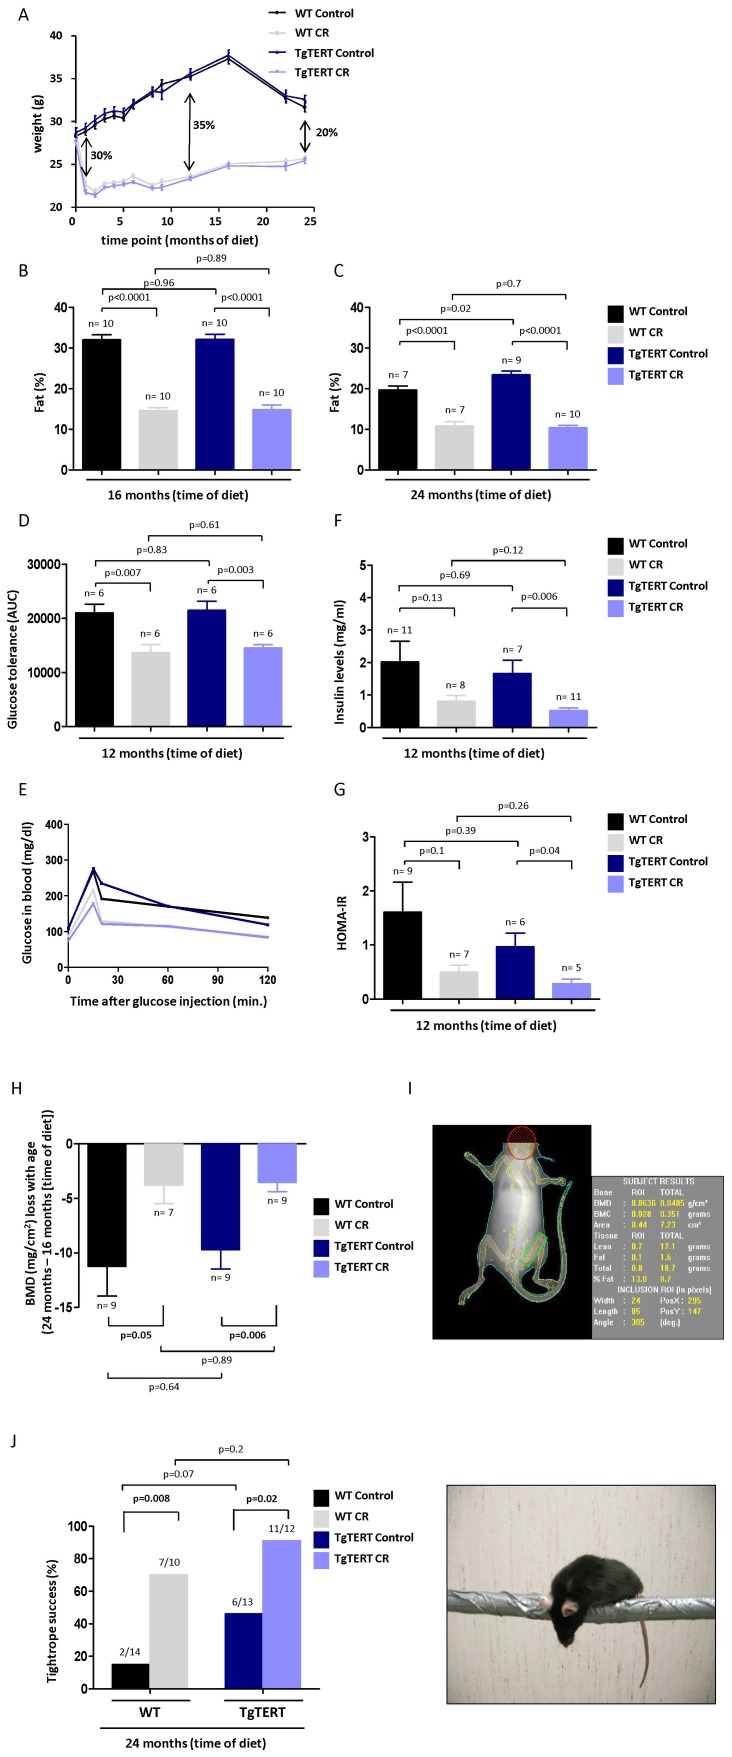
Impact of long-term calorie restriction on metabolic homeostasis and age-associated pathologies.(A) Weight given as average ± SEM of WT and TgTERT mice fed with control or CR diet (see Materials and Methods). One way ANOVA was used to assess statistical significance between the four groups (WT Control vs. Wt CR: p<0.0001; TgTERT Control vs. TgTERT CR: p<0.0001; WT Control vs. TgTERT Control: p = 0.72; WT CR vs. TgTERT CR: p = 0.46). (B and C) Total fat mass of the indicated cohorts was measured at 16 months of diet (B) and 24 months of diet (C). Values are given as average ± SEM, and statistical significance was determined by the two-tailed Student’s t-test. (D and E) Glucose tolerance test (GTT) was performed at 12 months of diet. Integrated AUCs (area under the curve; (D)) and curves (E) are shown. Values are given as average ± SEM, and statistical significance was determined by the two-tailed Student’s t-test. (F) Fasting plasma insulin levels, given as mean ± SEM, was measured in the different cohorts at 12 months of diet. Statistical significance was determined by the two-tailed Student’s t-test. (G) Insulin sensitivity, estimated using the homeostatic model assessment score (HOMA-IR), was performed at 12 months of diet. Values are given as average ± SEM, and statistical significance was determined by the two-tailed Student’s t-test. (H) Femur bone mineral density (BMD) variation through lifetime of WT and TgTERT mice under control and CR diets. Values are given as average ± SEM, and statistical significance was determined by the two-tailed Student’s t-test. (I) Representative DEXA image used for BMD and fat mass calculations. (J) Neuromuscular coordination was quantified as the percentage of mice that pass with success the tightrope test. Numbers above the bars represent the number of mice that successfully pass the test over the total number of mice tested. Student’s t-test was used to assess significance between control and CR mice. Values are given as average ± SEM, and statistical significance was determined by the two-tailed Student’s t-test.